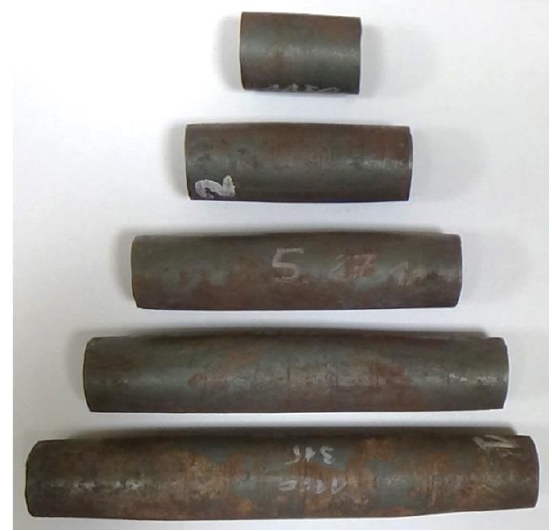
Figure 8. The samples deformed in the rotational compression of bars; respectively, from the top, the samples formed from billet with the length equal 30, 60, 90, 120 and 150 mm.